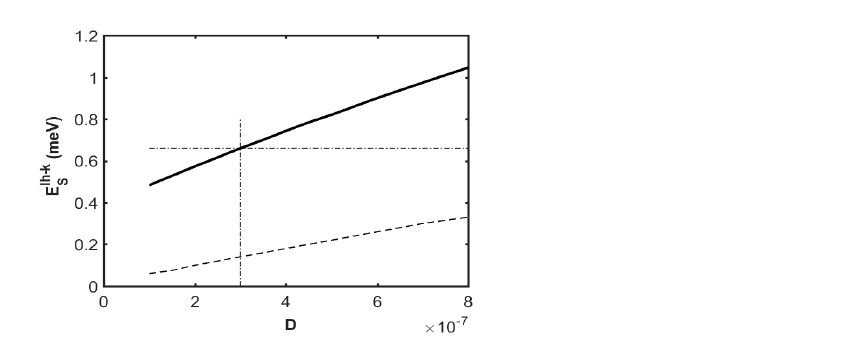
Figure 6. Binding energy E sll-k of the screened impurity state as a function of the oxide thickness D with the n s / T | a ≈ 6.6 × 10 7 cm − 2 / 0 K parameter (bold line) and n s / T | b ≈ 6.6 × 10 8 cm − 2 / 0 K parameter (thin line) for the InSb/SiO 2 /metal (ll- κ type) multi-layer quantum structure. As shown in Figure 5, the binding energy E sll-k values increase in parallel with the oxide thickness D , but the growth rates in cases (a) and (b) are quite different. In the first case, the binding energy grows significantly, increasing for the InSb bulk sample from values E s ≈ 0.66 meV (marked by a horizontal dashed-dotted line in the figure) at the oxide thickness D ≈ 2.84 × 10 − 7 nm (marked by a vertical dashed-dotted line) to an almost fourfold increased value ≈ 2. 52 meV (marked by a horizontal dashed-dotted line) at thickness D ≈ 6.75 × 10 − 7 nm (marked by a vertical dashed-dotted line), for which the effective radii have equal values ( a sc = ρ s = 23.74 nm in accordance with Figure 3). With the oxide thickness range D (cid:15) (3 ÷ 7 nm), the E sll-k ( D ) functional dependence might be